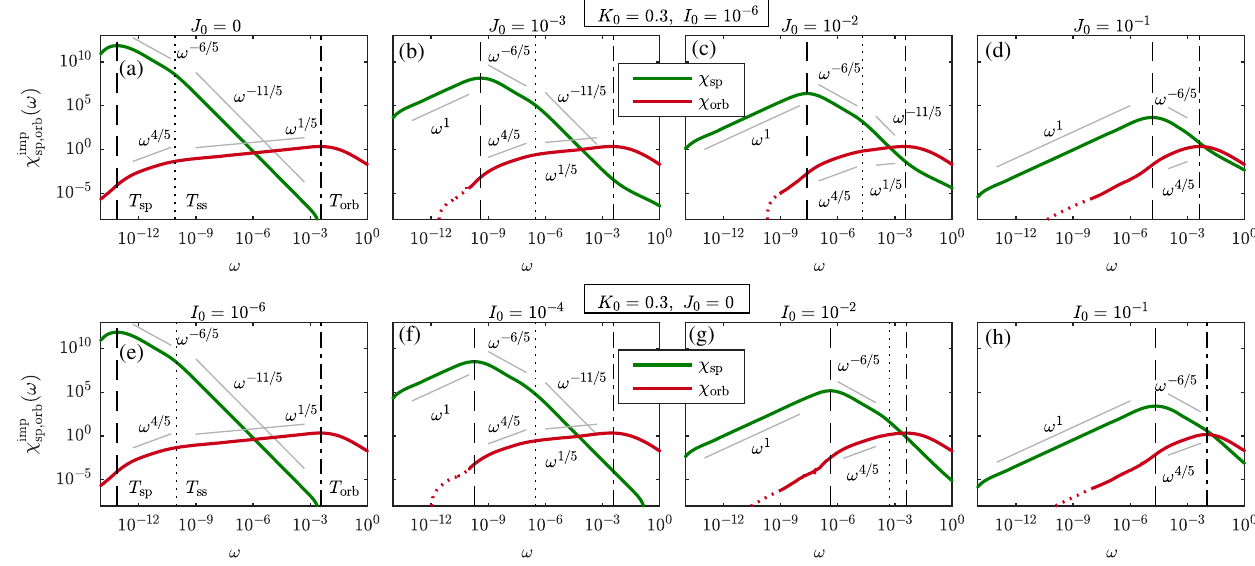
FIG. 4. Imaginary part of the zero-temperature impurity spin and orbital susceptibilities for the 3soK model. We keep K 0 ¼ 0 . 3 fixed throughout, and (a) – (d) vary J 0 at fixed I 0 ¼ 10 − 6 , or (e) – (h) vary I 0 at fixed J 0 ¼ 0 . (a) – (d) As J 0 is increased from 0 (left) to 10 − 1 (right), the width of the NFL regime ½ T behavior when increasing I 0 with K 0 and J 0 kept